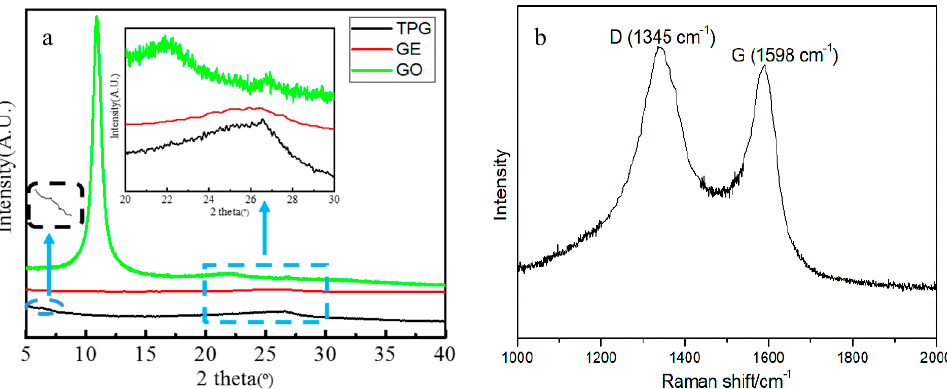
Figure 2. ( a ) X-ray diffraction (XRD) spectrum of TP/GE powder and GE; ( b ) Raman spectrum of tea polyphenols–graphene (TPG) solution.